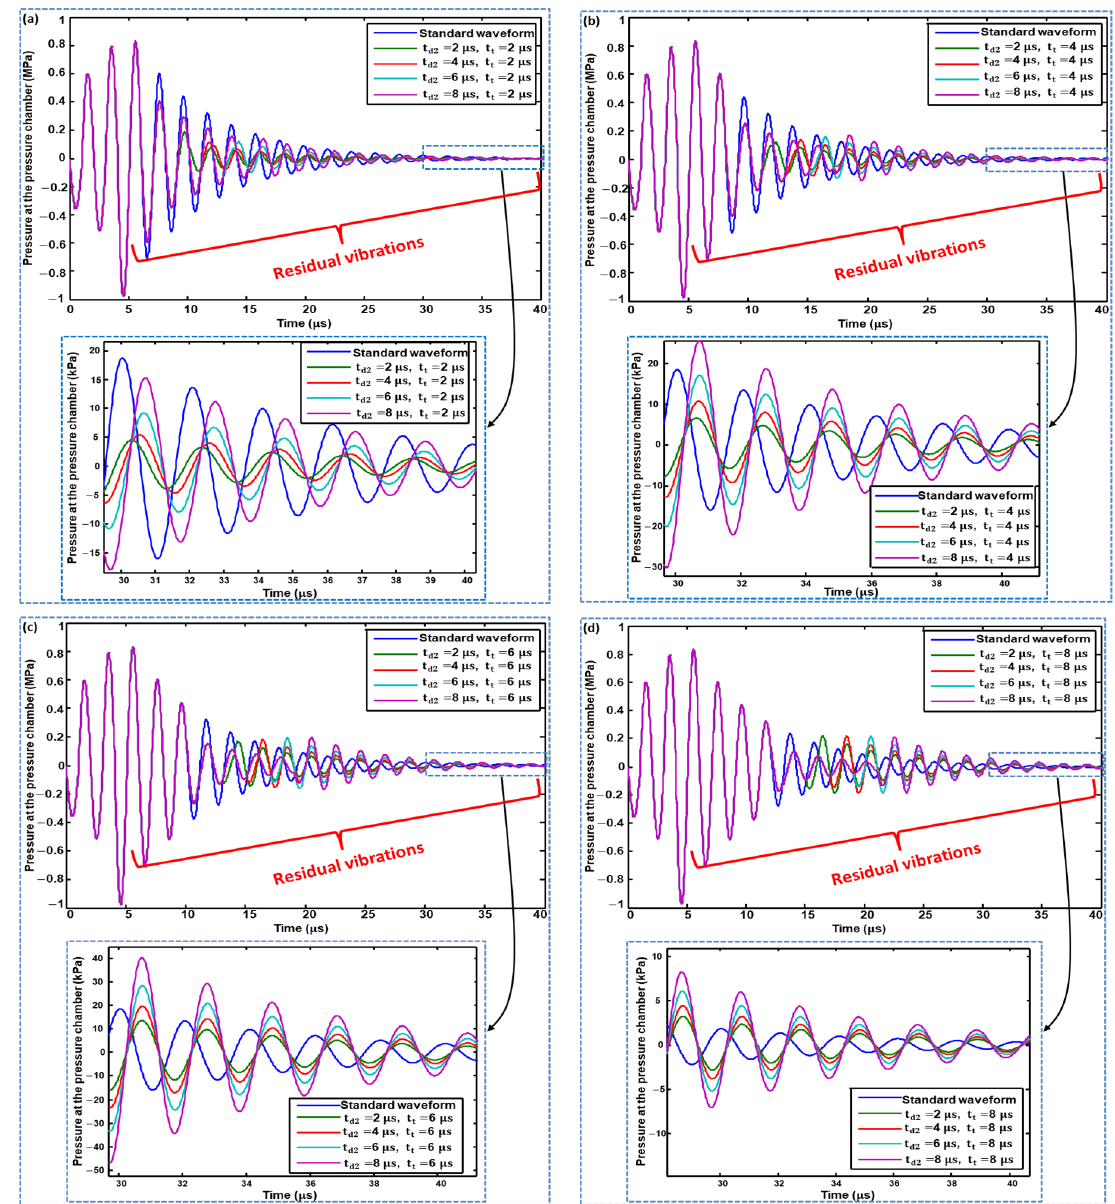
Figure 8. Effect of changing the dwell time of the second pulse of Waveform 01 on residual vibrations when tuning time is: ( a ) 2 μs ; ( b ) 4 μs ; ( c ) 6 μs ; and ( d ) 8 μs . The second pulse has no effect on the jetting pressure. The optimized parameters of Waveform 01 are presented in Table 1. Table 1. Optimized parameters of both waveforms for suppressing residual vibrations. Waveform 02 Waveform 01